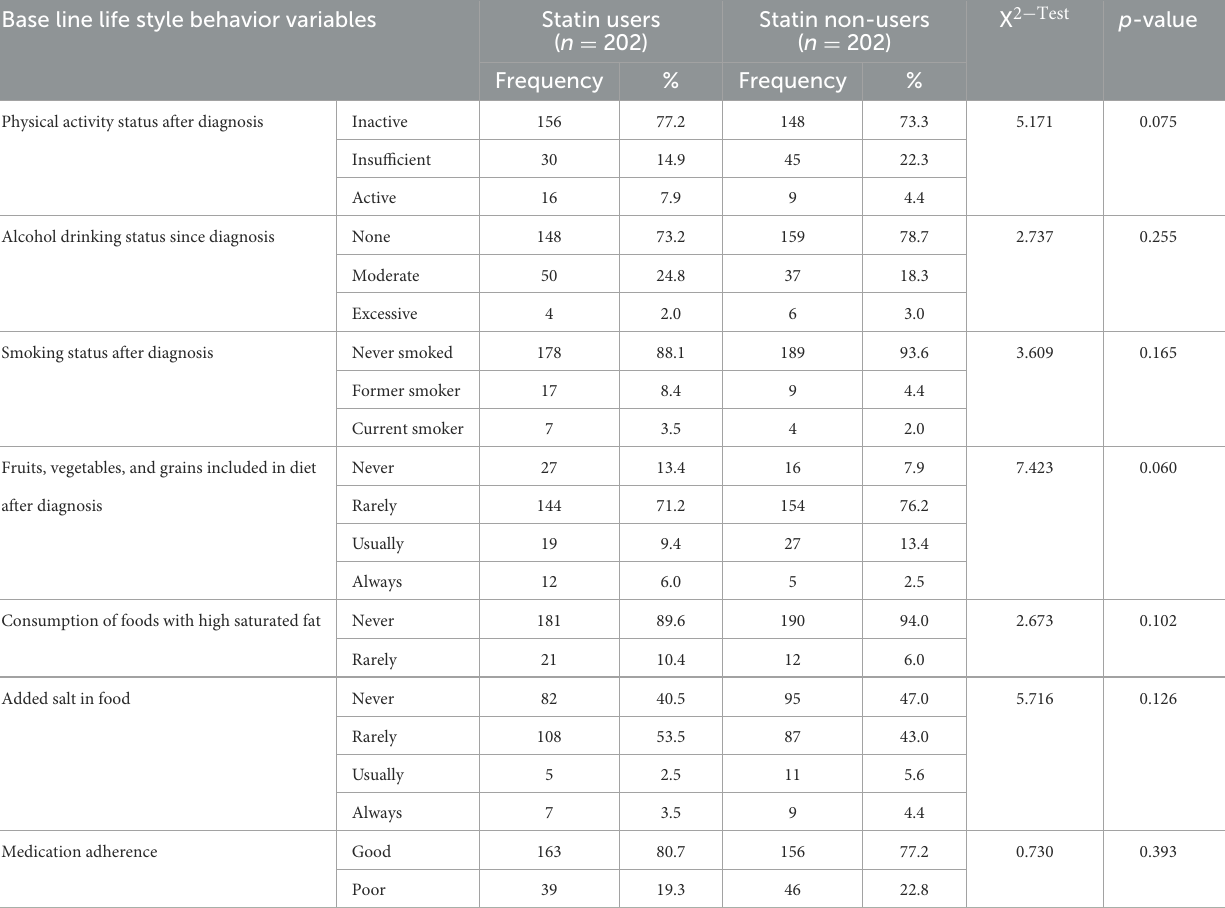
TABLE 2 Lifestyle/behavioral features of patients with hypertension attending the outpatient clinic at FHCSH, northwest